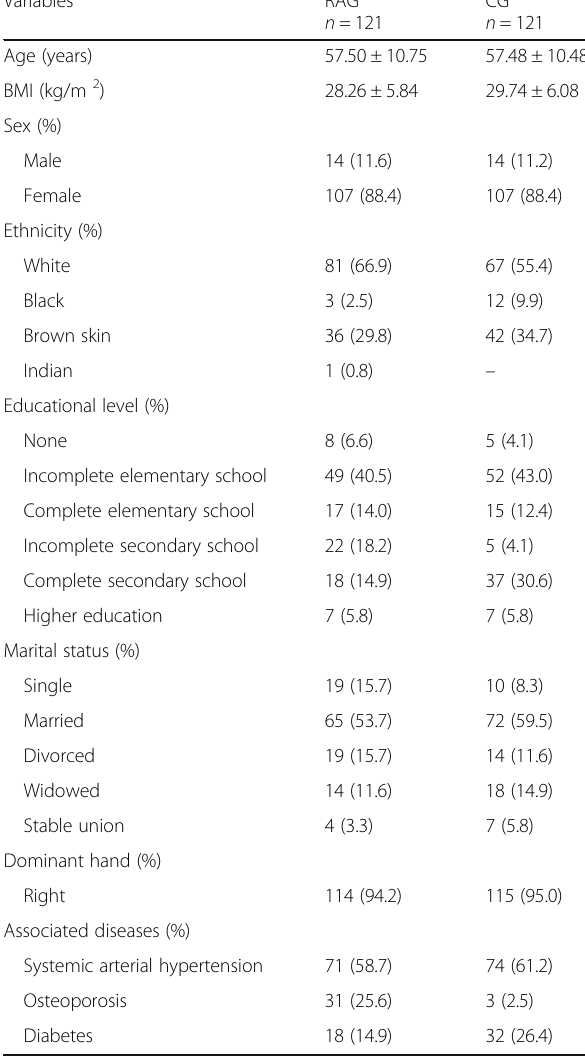
Table 1 Characteristics of the rheumatoid arthritis group (RAG) and the control group (CG)